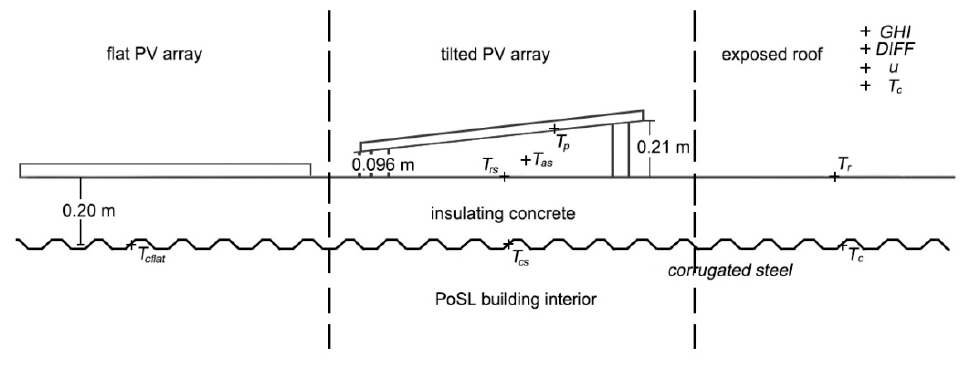
( a ) Figure 4. Cont